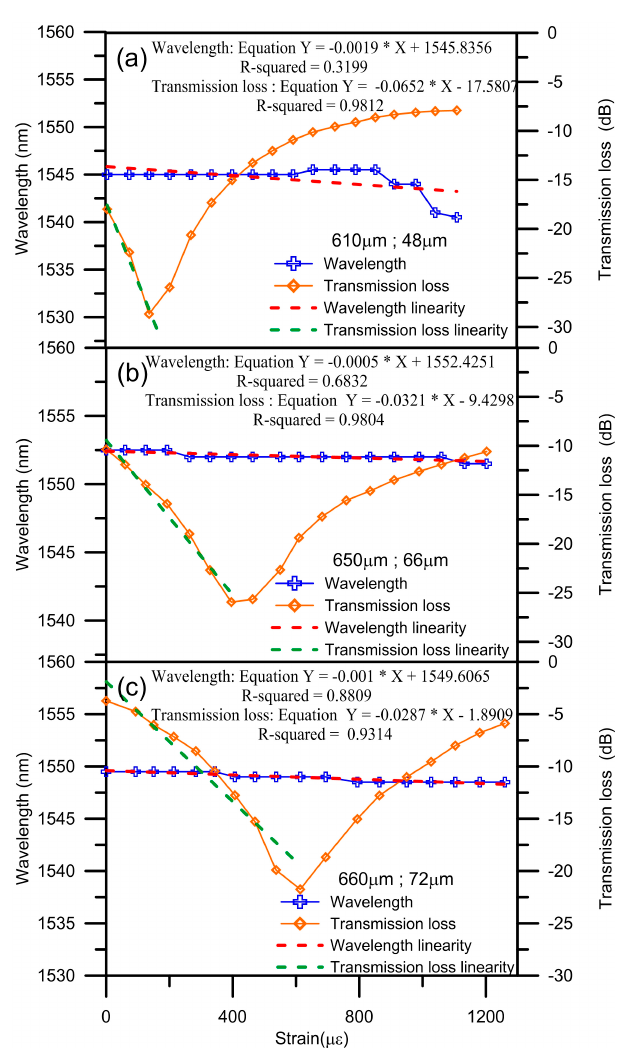
Figure 5. Transmission loss versus wavelength of the PLPFG under various strain loadings: ( a ) period 610 μ m, diameter 48 μ m, ( b ) period 650 μ m, diameter 66 μ m, and ( c ) period 660 μ m, diameter 72 μ m.